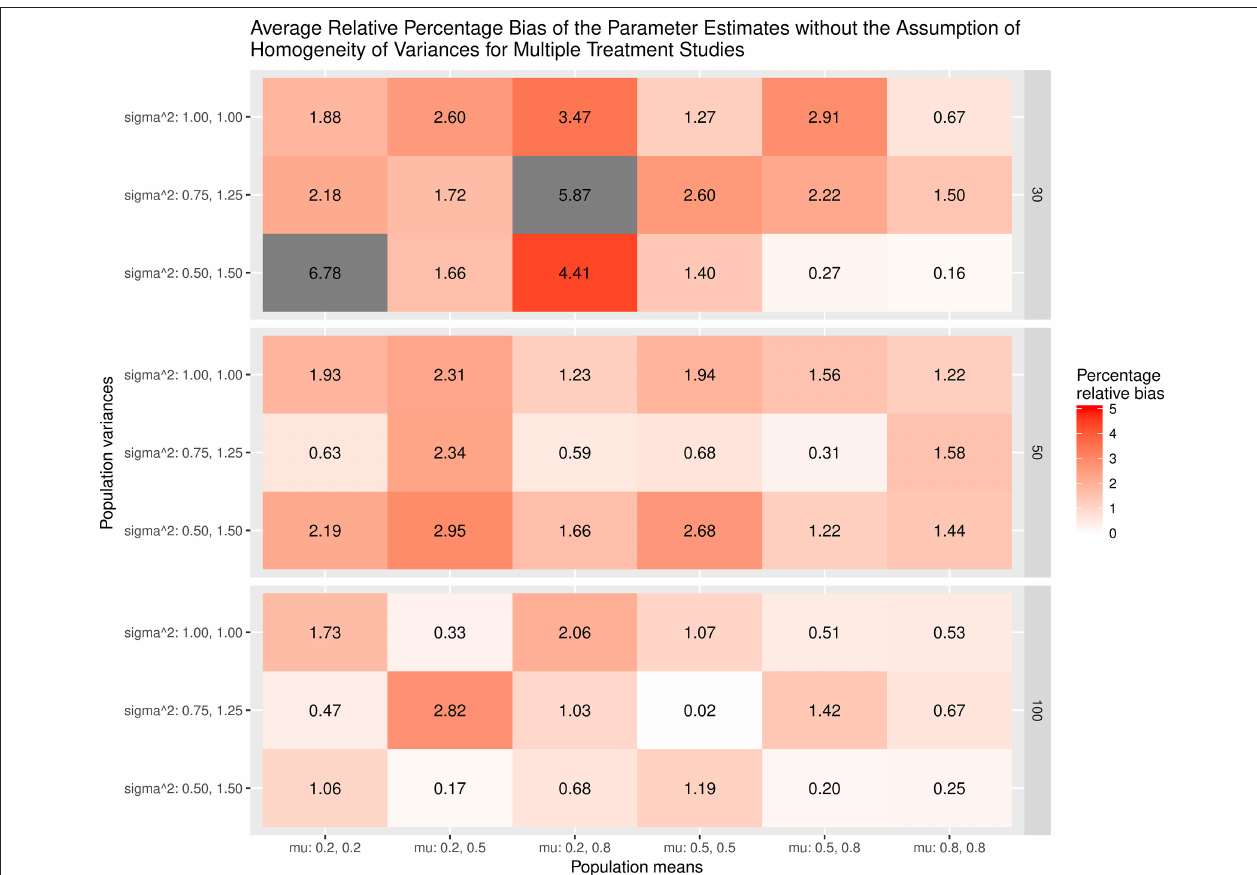
FIGURE 4 | Relative bias of the average of parameter estimates for the multiple treatment studies without the assumption of homogeneity of variances.